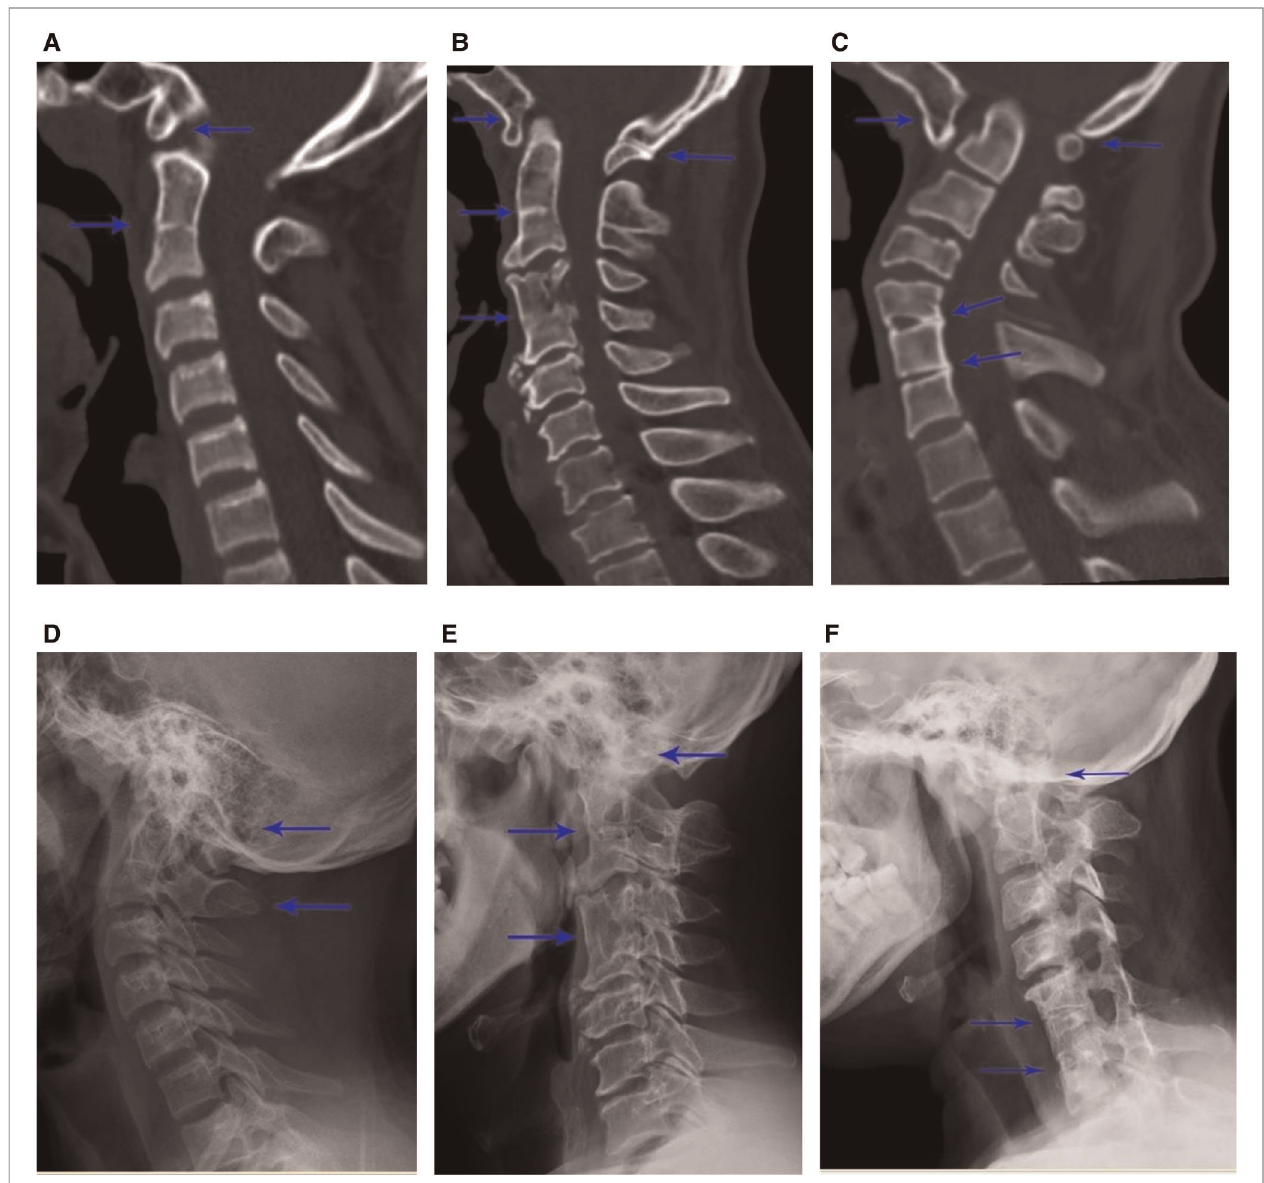
FIGURE 1 | Patients with Klippel – Feil syndrome (KFS) and occipital fusion. Examples of different types of KFS patients with occipital fusion: type I – ( A ) computed tomography (CT) scan and ( D ) radiograph showing C2 – 3 single fusion with occipital fusion; type II – ( B ) CT scan and ( E ) radiograph showing noncontiguous levels of fusion (C2 – 3 and C4 – 5) with occipital fusion; type III – ( C ) CT scan and ( F ) radiograph showing three levels of contiguous fusion at C5-7 with occipital fusion. The site of fusions is indicated by arrows